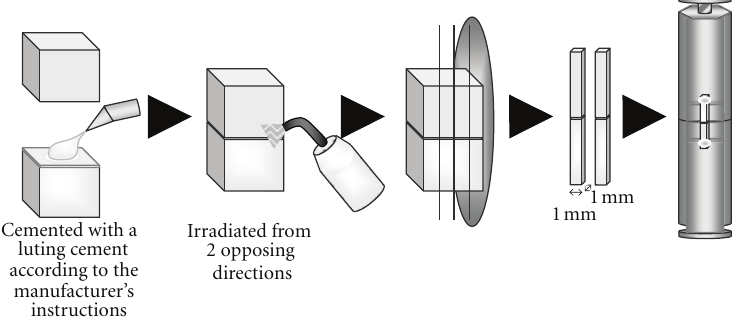
Figure 2: Schematic illustration of the procedure for μ TBS